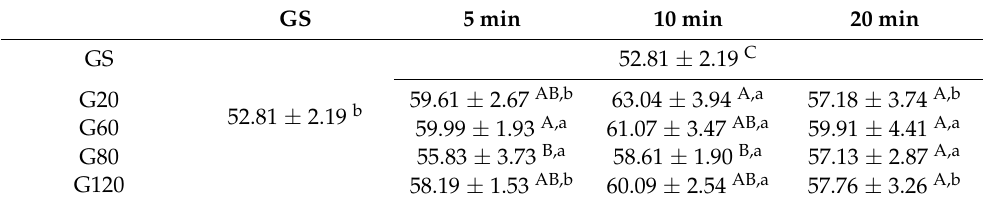
Table 2. Surface degree of conversion of the specimen for post-curing intensity and time (mean ±